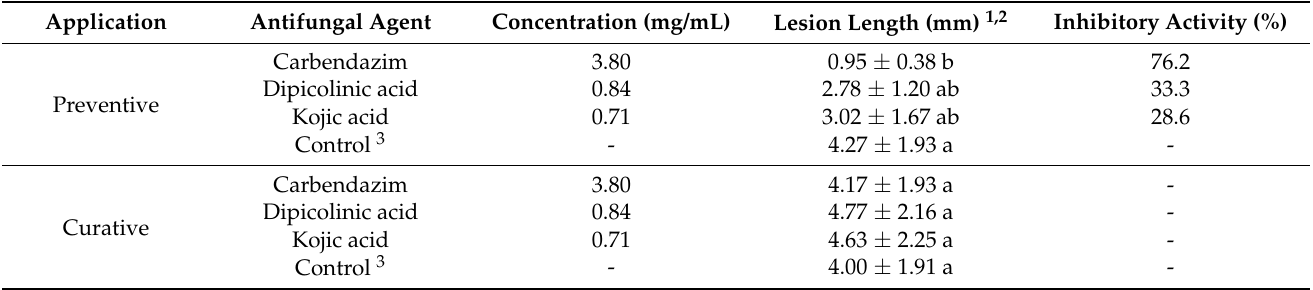
Table 1. Efficacy of carbendazim, dipicolinic acid and kojic acid against Fusarium sulawense on soybean